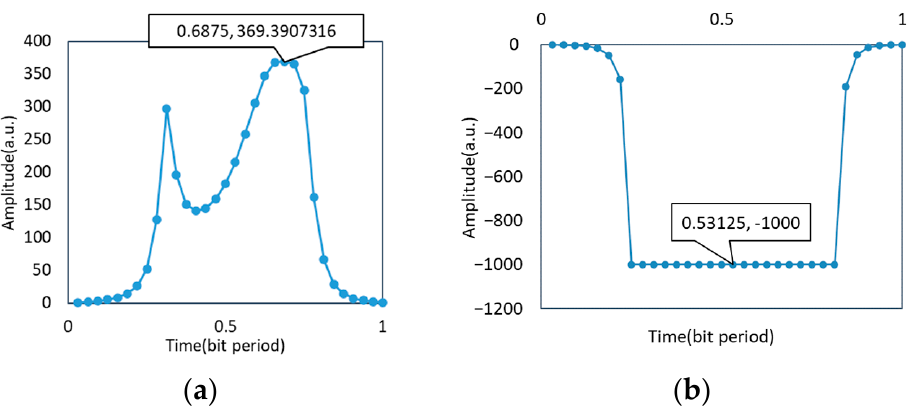
Figure 8. Communication quality without phase difference in the transmission of two optical signals: ( a ) Q factor without phase difference; ( b ) BER without phase difference. The power values of the three cases were recorded. Under ideal conditions, the power was 2.75 mW. Additionally, the power decreased to 3.30 × 10 − 6 W, when the phase difference of π /2 was added. It increased to 2.62 mW after phase correction, and the power was significantly